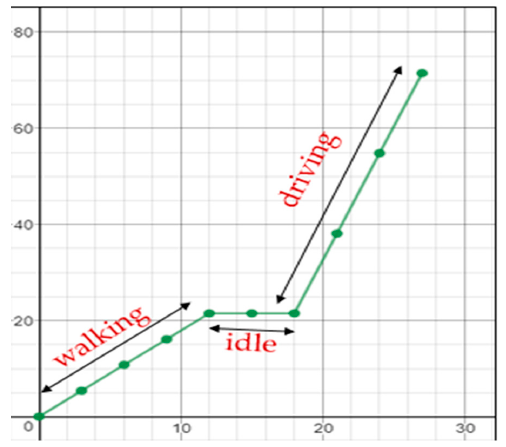
Figure 5. Walking, idle and driving graph (speed vs. time).